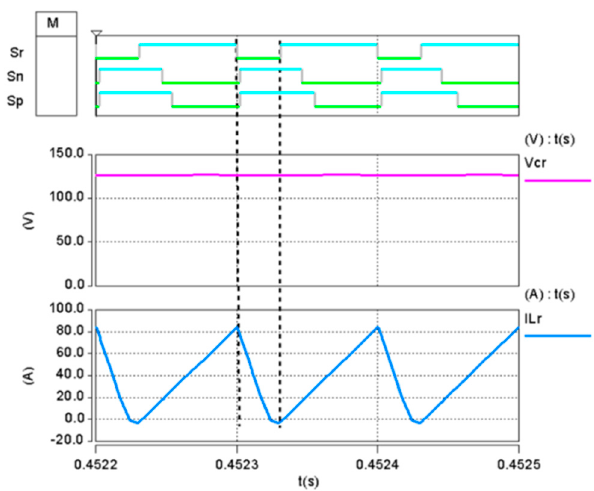
Figure 11. Inductance current and clamping capacitance voltage of auxiliary circuit.